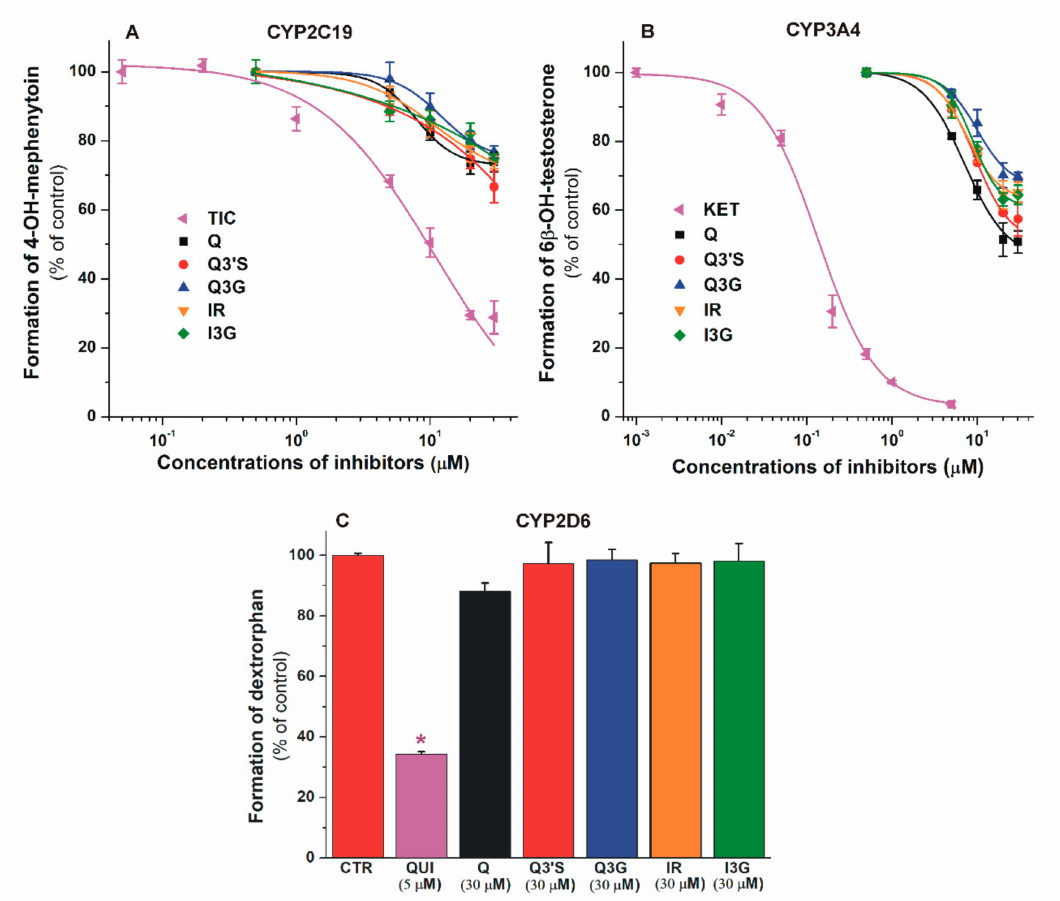
Figure 2. Inhibitory e ff ects of Q, Q3 (cid:48) S, Q3G, IR, I3G, and positive controls on cytochrome P450 (CYP)2C19 ( A ), 3A4 ( B ), and 2D6 (( C ); * p < 0.01) enzymes. Inhibition of CYP2C19-catalyzed S-mephenytoin hydroxylation (positive control: ticlopidine, TIC; IC 50 = 4.3 µ M), CYP3A4-catalyzed testosterone hydroxylation (positive control: ketoconazole, KET; IC 50 = 0.2 µ M), and CYP2D6-catalyzed dextromethorphan O -demethylation (positive control: quinidine, QUI; IC 50 = 0.2 µ M) by flavonoids (substrate concentrations: 5 µ M in each assay). CYP2C19: statistically significant (p < 0.01) decrease in metabolite formation was induced by 5 µ M of TIC, 10 µ M of Q, and 20 µ M of Q3 (cid:48) S, Q3G, IR, and I3G. CYP3A4: statistically significant ( p < 0.01) decrease in metabolite formation was induced by 0.05 µ M of KET, 5 µ M of Q, 20 µ M of Q3G, and 10 µ M of Q3 (cid:48) S, IR, and I3G (Q, quercetin; Q3 (cid:48) S, quercetin-3 (cid:48) -sulfate; Q3G, quercetin-3-glucuronide; IR, isorhamnetin; I3G,